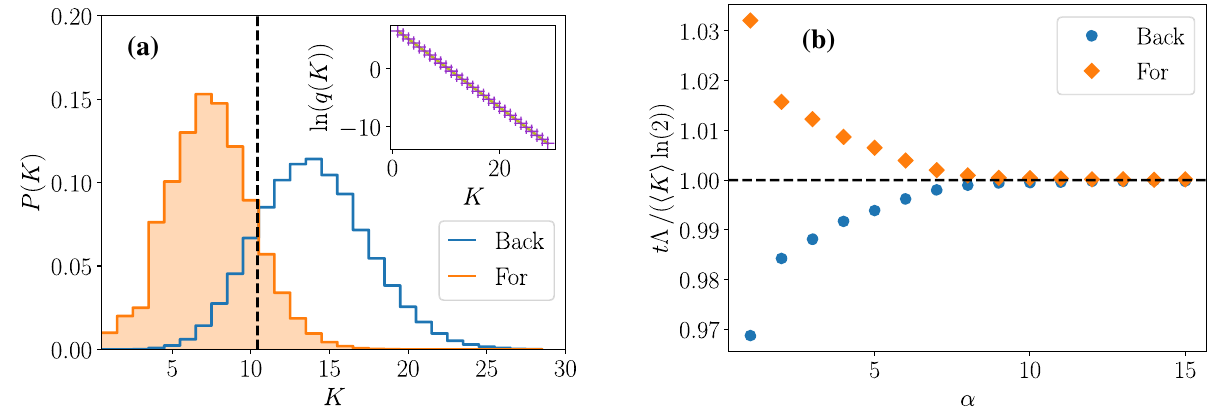
Figure 3. Illustration of (a) the fluctuation relation for the number of divisions and (b) the inequality on the mean number of divisions, for a size-controlled model with division rate B ( x ) = ν x α . In ( a ), the forward distribution is shown as orange filled histogram and the backward distribution as blue empty histogram. The vertical dashed line at K = t � t / ln 2 is the theoretical value at which the two distributions should intersect. The inset shows the logarithm of the ratio q ( K ) of the forward to backward probabilities (purple crosses), and the theoretical result t (cid:31) t − K ln 2 (green line). The conditional probability �( x | x ′ ) is uniform between sizes 0 and x ′ . The simulation was conducted with constant ν = 1 , α = 2 and t = 7 . In ( b ), the quantity t / (cid:31) K (cid:30) , re-scaled by the population doubling time T d = ln 2 /� t , is plotted when α is varied from 1 to 15, with orange diamonds for the forward sampling and with blue circles for the backward sampling. The volume partition between the two daughter cells at division is symmetrical, so that �( x | x ′ ) = δ( x − x ′ / 2 ) . The simulation was conducted with constant ν = 1 , and t = 6